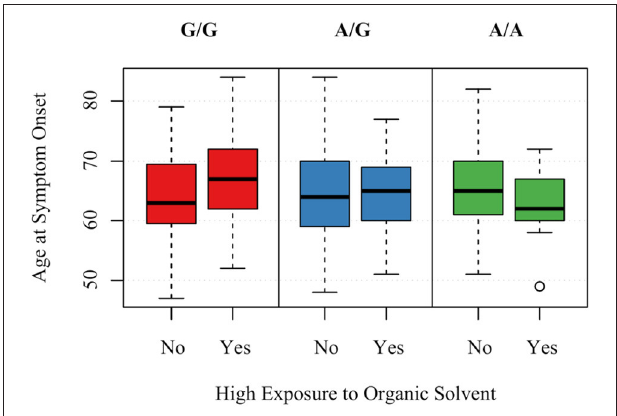
FIGURE 3 | Association between age of PSP symptom onset and the interaction of STX6rs1411478 and exposure to organic solvents. A is the minor allele, G is the major allele for STX6rs1411478; G/G corresponds to 0 minor allele, A/G corresponds to 1 minor allele, A/A corresponds to 2 minor